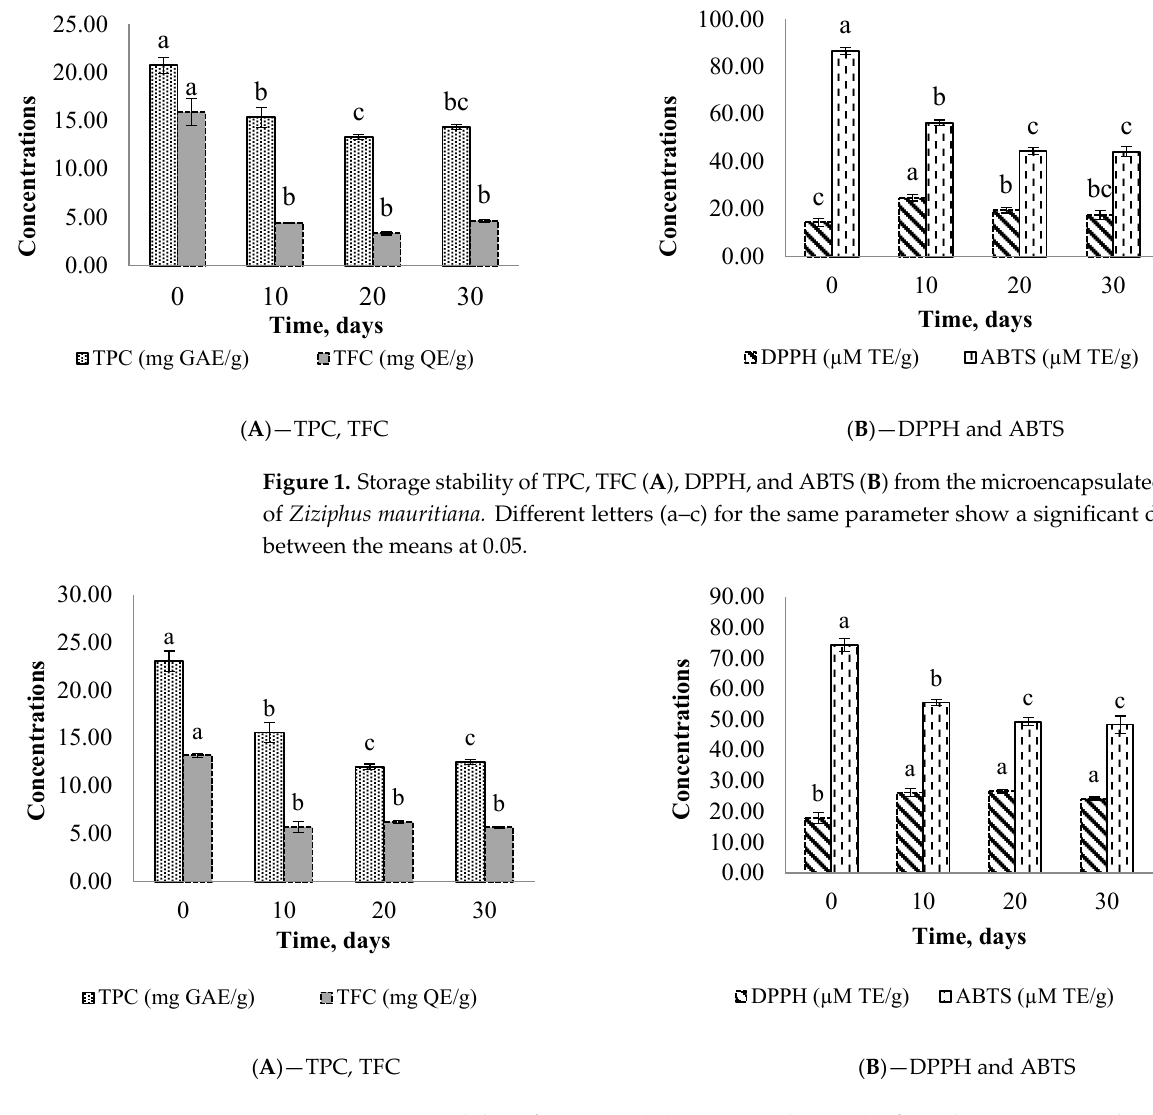
Figure 2. Storage stability of TPC, TFC ( A ), DPPH, and ABTS ( B ) from the microencapsulated powder of Balanites aegyptiaca. Different letters (a–c) for the same parameter show a significant difference between the means at 0.05.